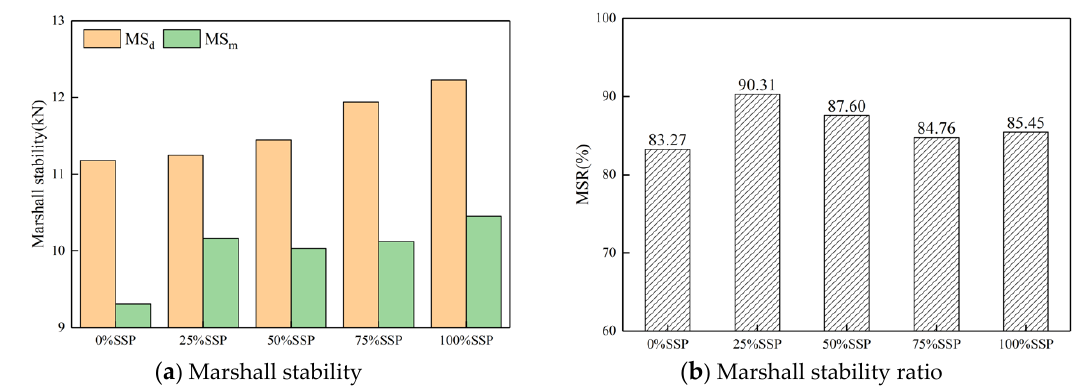
Figure 8. MS and MSR of samples with different fillers with the same substitution.